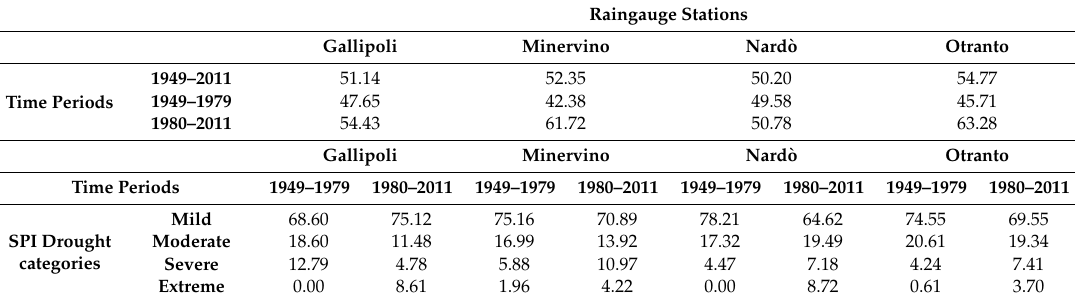
Figure 4. SPI in the period 1949–2011, evaluated, for ( a ) Nardò, ( b ) Otranto, ( c ) Minervino di Lecce and ( d ) Gallipoli. The year marks are centred on 1 July of each year. Table 6. Distribution (%) of di ff erent types of